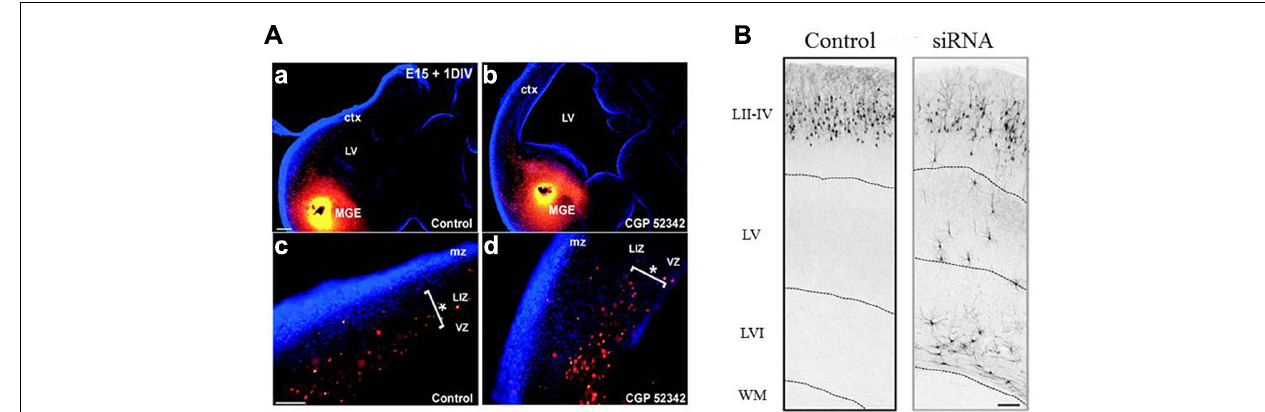
d). Asterisks at (c,d) represent where the majority of the CMTMR-positive cells were localized. Abbreviations: ctx, cortex; LIZ, lower intermediate zone; mz, marginal zone;VZ, ventricular zone. Scale bars: a,b 200 μ m, c,d 100 μ m. Modified with permission from Lopez-Bendito etal. (2003). (B) Confocal images of tdTomato fluorescence in coronal sections of rat somatosensory cortices P16 after in utero transfection (at E17) with pRNAT-U6.3 (EGFP) siRNA empty vector together with pCAG-IRES-tdTomato (Tomato, Control), or functional GABA B2 -siRNA (siRNA) together withTomato construct. Dotted white lines delimitate the boundaries of the cortical layers. Note the presence of ectopic neurons that did not complete radial migration in the layersV and VI. Scale bar: 150 μ m. LII–LIV, layer II–IV;WM, white matter. Modified with permission from Bony etal.